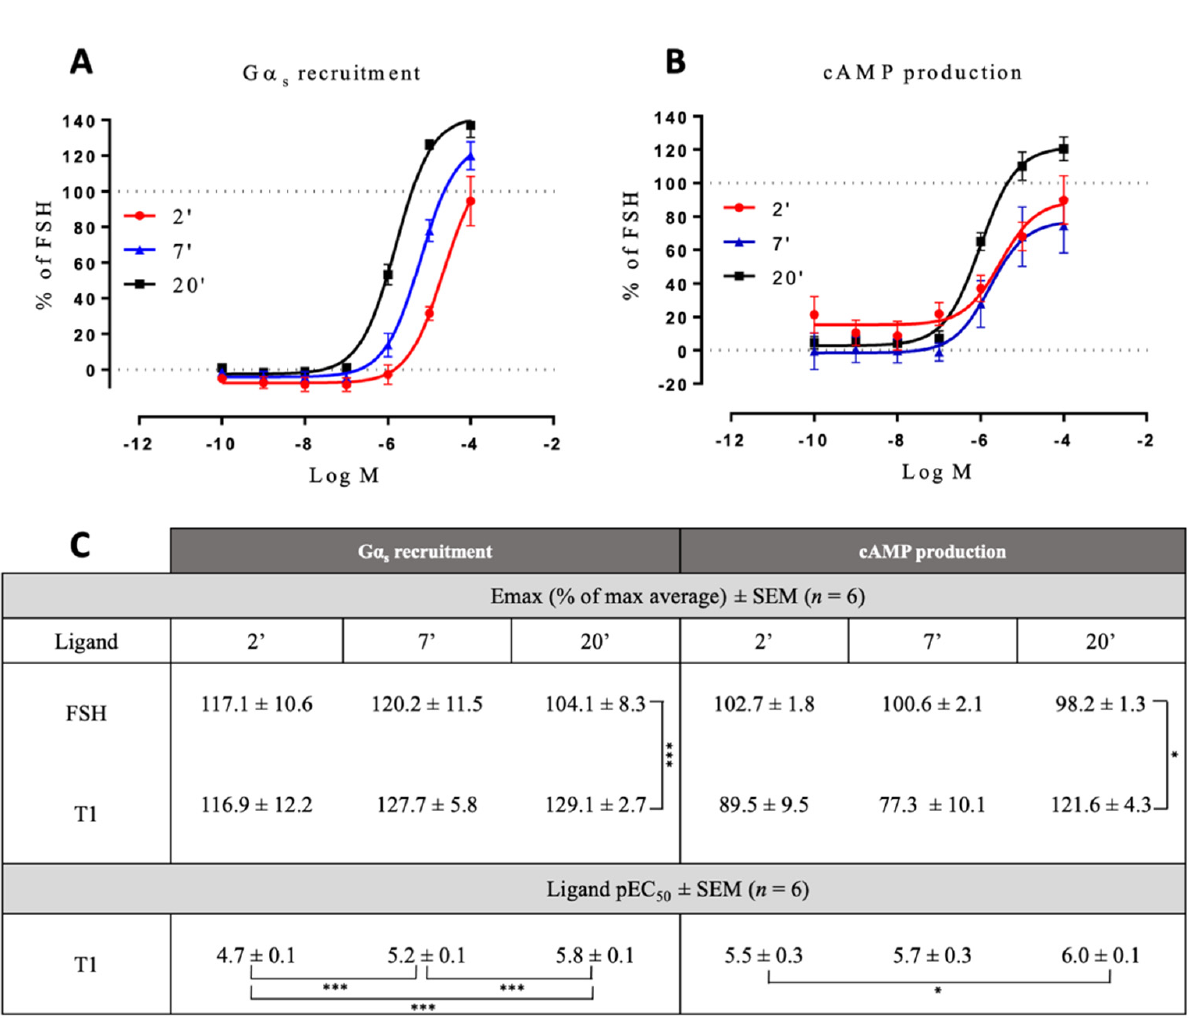
Figure 4. Concentration/activity curves of T1 vs. FSH at different time points. G α s recruitment ( A ) and cAMP production ( B ) were measured at 2, 7, and 20 min of stimulation. Efficacies and potencies were compared ( C ). The area under the concentration/activity curves generated by T1 at the different endpoints considered (2, 7, and 20 min) were calculated. FSH maximal response at each endpoint was set at 100%, and T1-induced values were normalized accordingly. Normalized values were plotted and fitted using non-linear regression. Emax values were represented as the % of FSH Emax ± SEM. Potency values were represented as the positive logarithm of the ligand EC 50 concentration ± SEM for each time considered. Statistical significance was assessed by unpaired t-test with Welch’s correction. n = 6, * p < 0.05; *** p < 0.001.